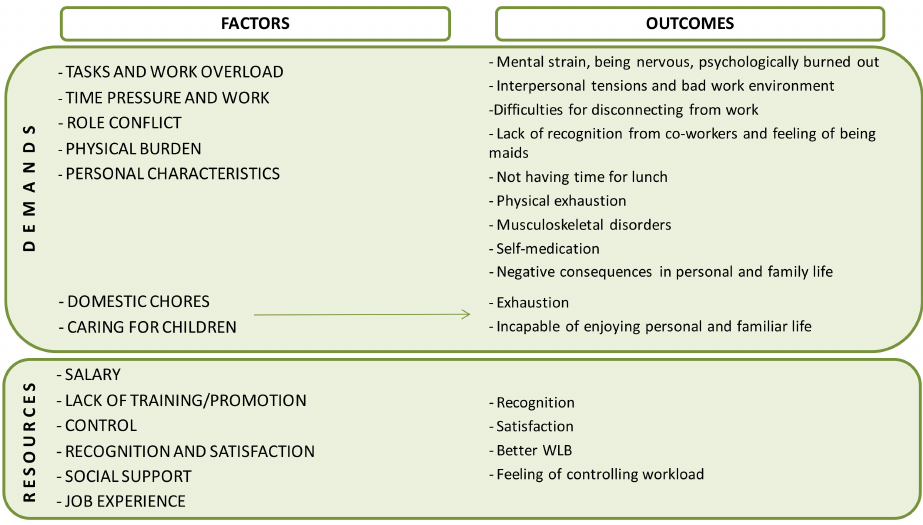
Figure 2. Demands and resources perceived and their